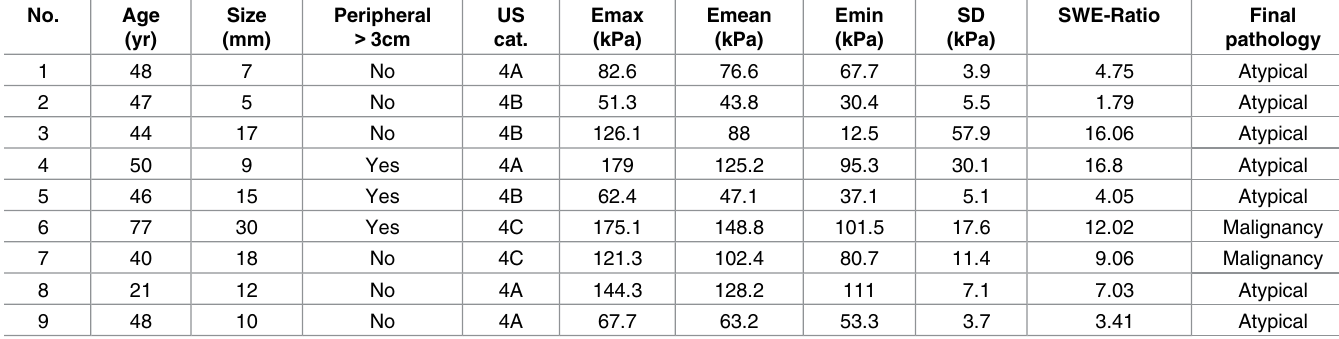
Table 1. Summaryof cases upgraded to atypical papilloma or malignancy after excision. No.